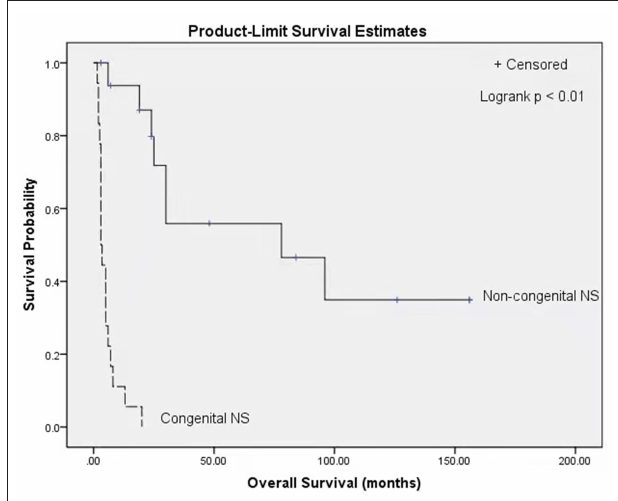
FIGURE 1 | Kaplan Meier survival curves stratified by classification of congenital NS (congenital NS: n = 18, non-congenital NS: n = 17; p < 0.01, log-rank test). NS, Nephrotic